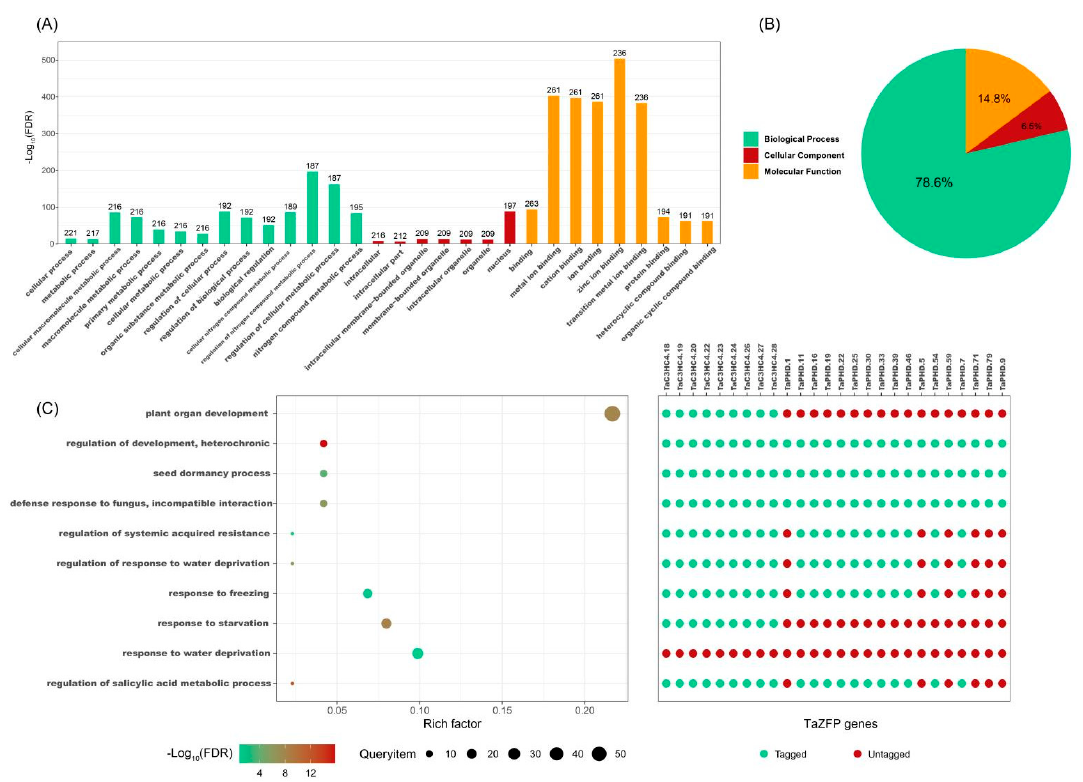
Figure 5. Gene ontology (GO) enrichment analysis of 269 TaZFP s under drought stress. ( A ) Top thirty most annotated GO items. ( B ) The proportion of different GO annotations. The cut-off value is FDR ≤ 0.05 for 501 GO entries. ( C ) Representative TaZFPs are assigned to categories related to development, stress, and hormone response and regulation. Green circles indicate that the gene does not belong to this category; red circles indicate that the gene belongs to the relevant category; the colour gradient indicates the size of the -Log10 (FDR) value; the size of the circle indicates the number of TaZFPs; the ‘Rich factor’ refers to the number of TaZFPs as a proportion of the total number of genes. all four ZFP subfamilies involved (Figure 6). TaPHD members, which occupy the central part of the most complex network, still play an important role, with a total of 23 proteins